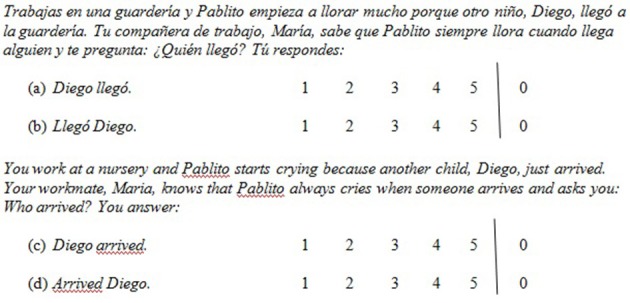
Sample stimulus.